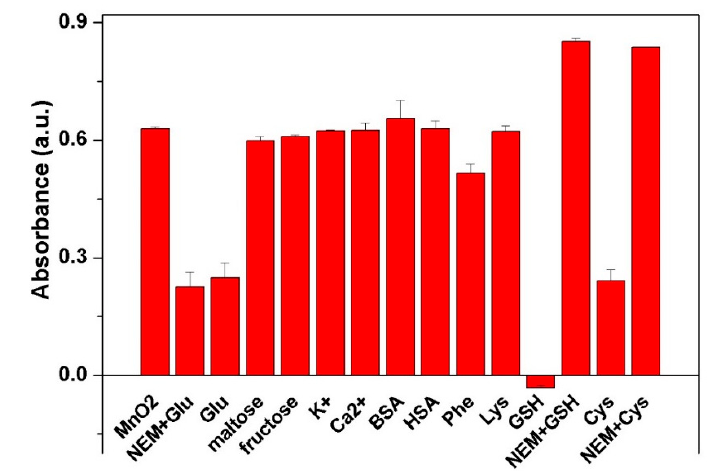
Figure 5. Comparision of the specificity of this method for the detection of 50 μ M glucose towards several common interferences of maltose, fructose and metal ions (500 μ M), and BSA, HSA (1%) and GSH, Cys (50 µ M). Note: Error bars represented the SDs from three independent detections.